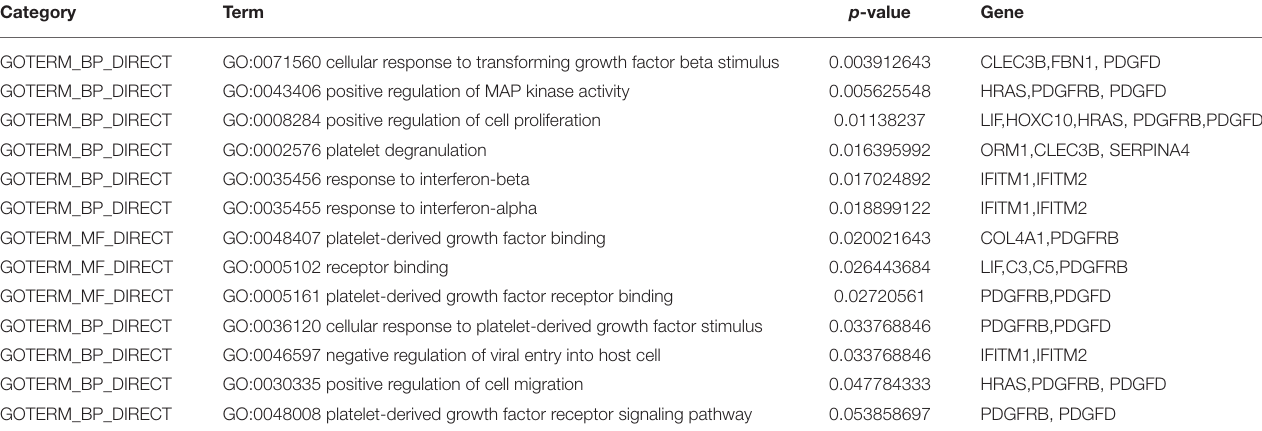
TABLE 6 | GO analysis of selected